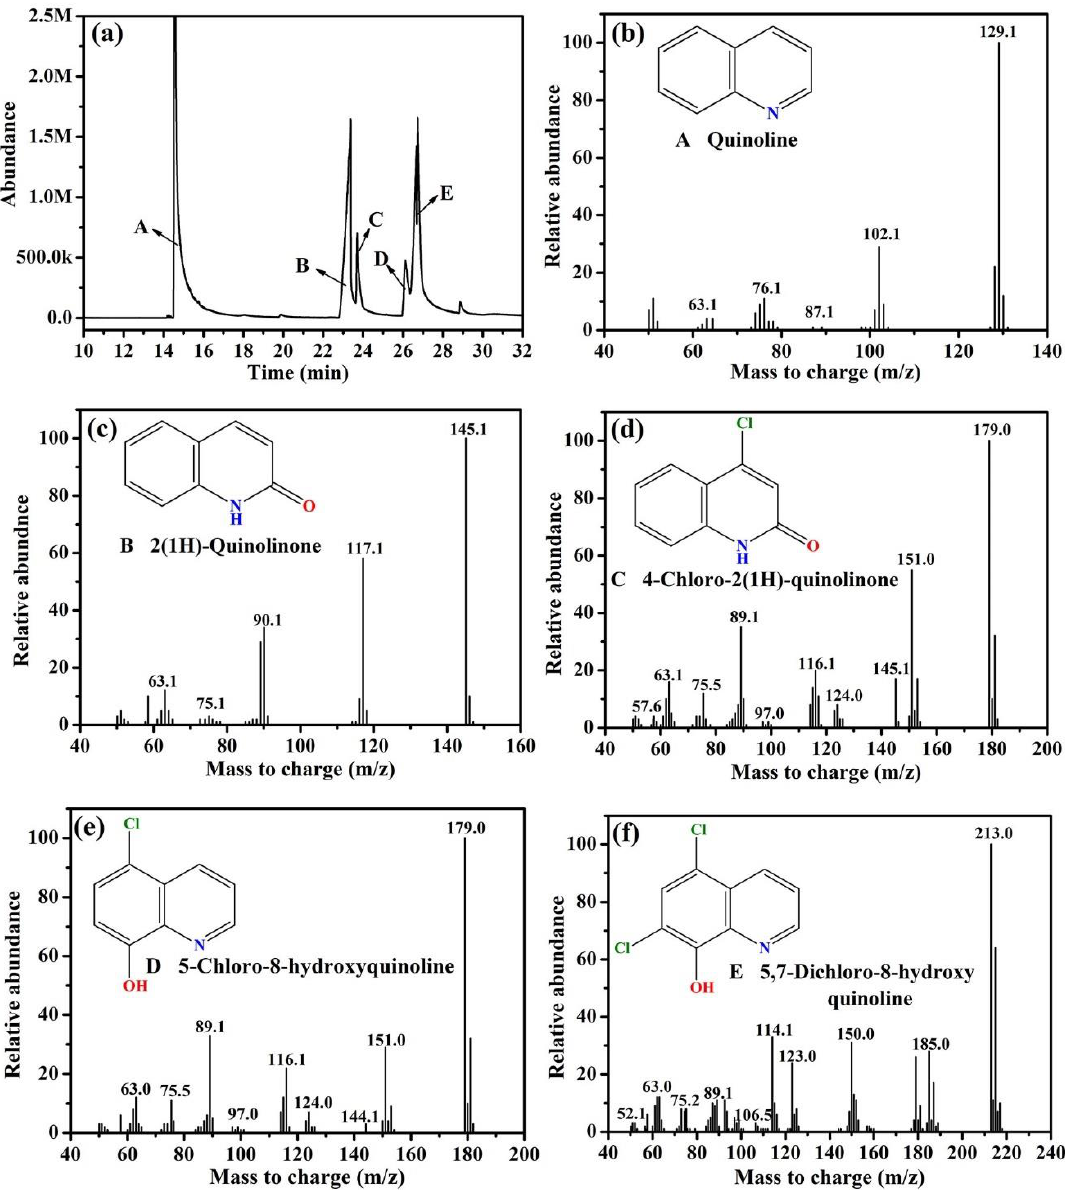
Figure 5. ( a ) GC–MS chromatogram of quinoline solution treated by the E-Fenton process for 20 min, and ( b – f ) mass spectra of main intermediates during quinoline degradation.